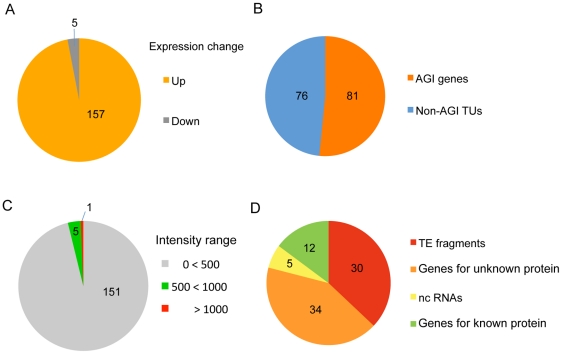
HDA6 is required for genome-wide gene silencing of TE fragments and
other silenced loci.Transcript profiling of the hda6 mutant,
axe1-5, using a tiling array revealed that the
hda6 mutation resulted in derepression of 157 loci
including TE fragments and other silenced regions. (A) The fractions of
the loci upregulated (orange) or downregulated (grey) in
axe1-5. The 157 upregulated loci accounted for
97% of differentially expressed loci. (B) The fraction of AGI
genes (red) and non-AGI TUs (blue) out of the loci upregulated in
axe1-5. (C) The fraction of silenced loci (signal
intensity <500) in wild-type plants (grey) out of the loci
upregulated in axe1-5. (D) Functional classification of
upregulated AGI genes in axe1-5. TE fragments (red;
37%); genes for unknown proteins (orange; 42%); ncRNA
(yellow; 6%); genes for known proteins (green; 15%).